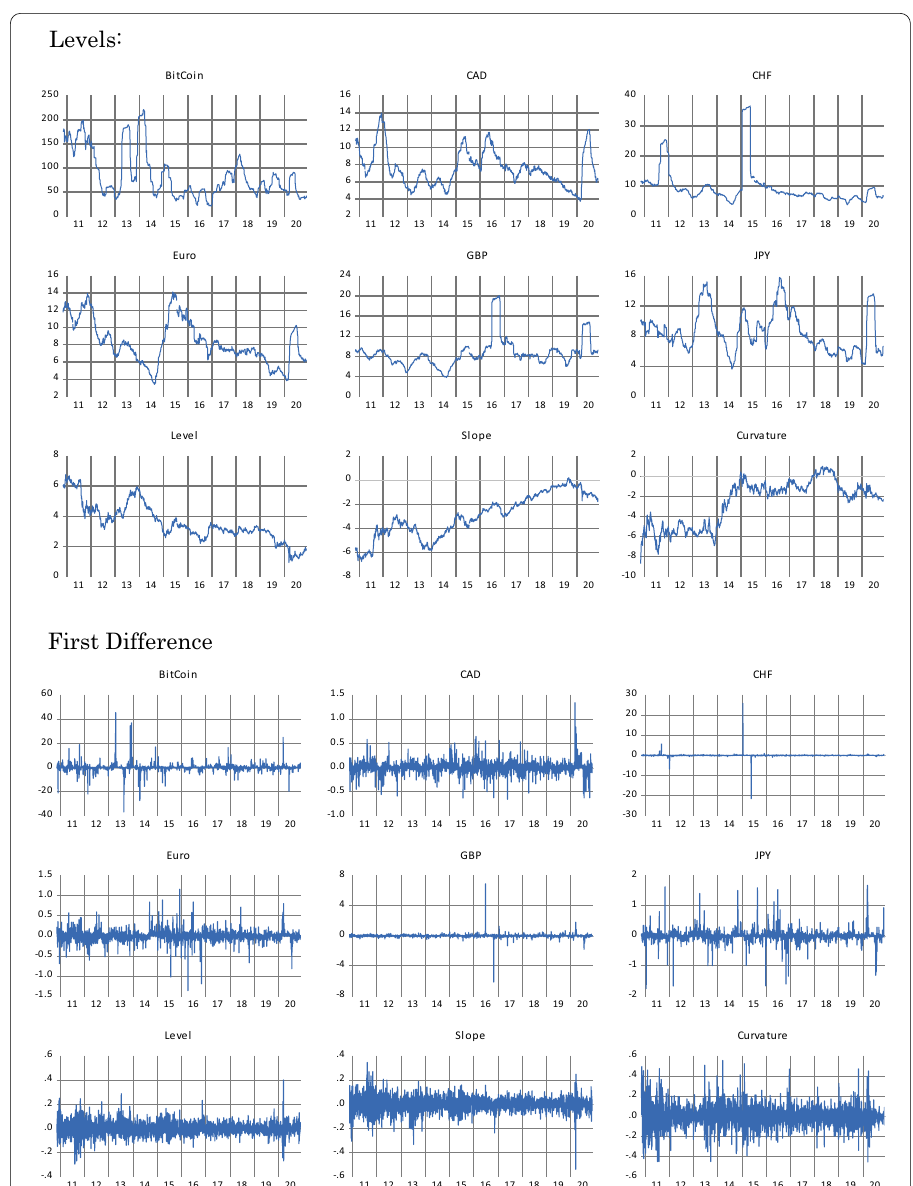
Fig. 5 Levels and First Difference of the Volatility of the Exchange Rates and the Components of the Yield Curve. Notes : This figure shows the level and first difference of the historical volatility of Bitcoin and the fiat currencies in the top and bottom panels, respectively. The levels and first difference of the components of the yield curve are also